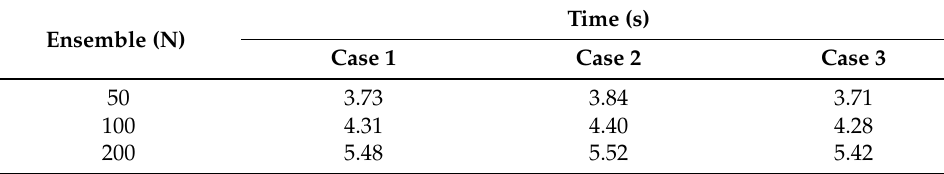
Table 4. Computational time of the proposed modified EnKF algorithm ( T = 0.01